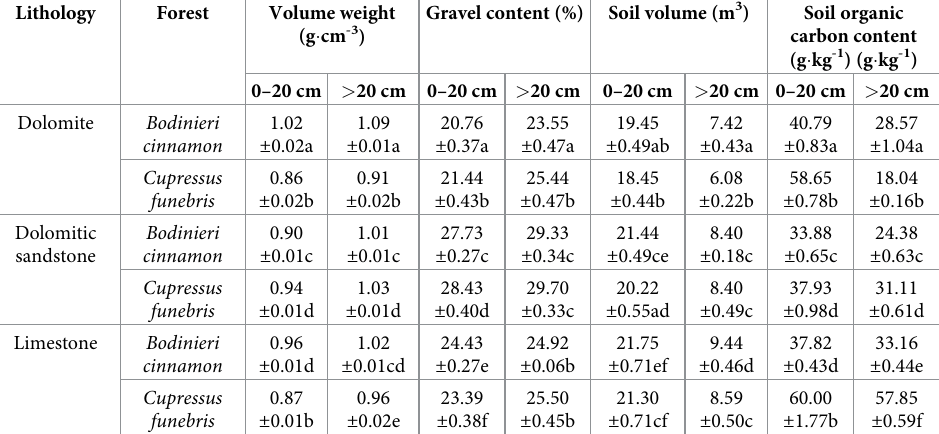
Table 10. Soil volume weight, gravel content, volume, and organic carbon content of the two plantations under different